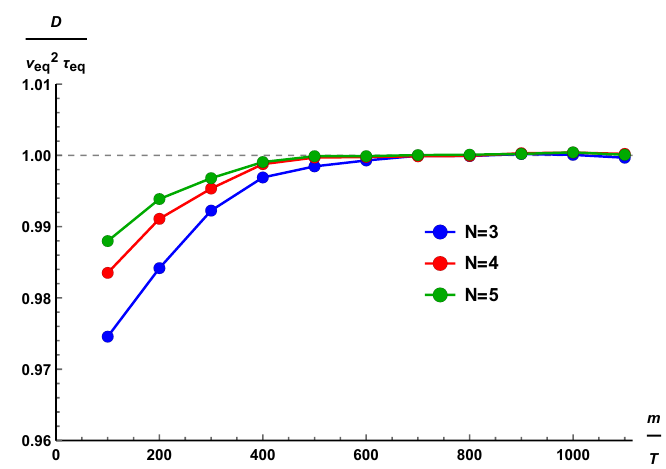
Figure 6 . The dimensionless ratio D/ ( v 2 for various powers N = 3 , 4 , 5 . All the curves approach the unit value at low temperature. Moreover, all curves are consistent with the inequality D ≤ v 2